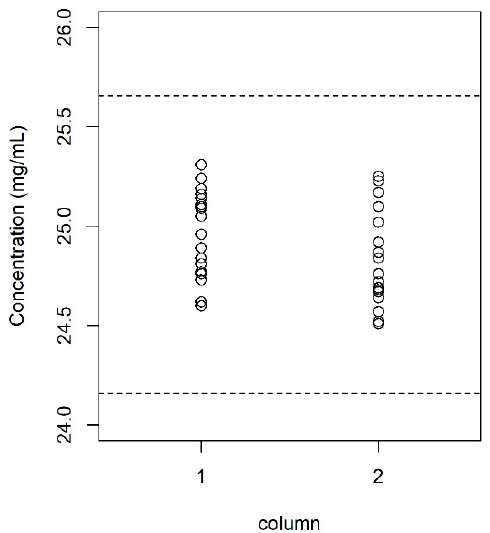
Figure 2. Experimental data obtained for two SEC columns used in this study. The mean and standard deviation obtained were 24.97 and 0.271 mg/mL for the column #1, whereas for the column #2, they were 24.84 and 0.254 mg/mL, respectively. The dashed line corresponds to the limits established at x ± 3 σ . In this case, σ = 0.236 mg/mL.